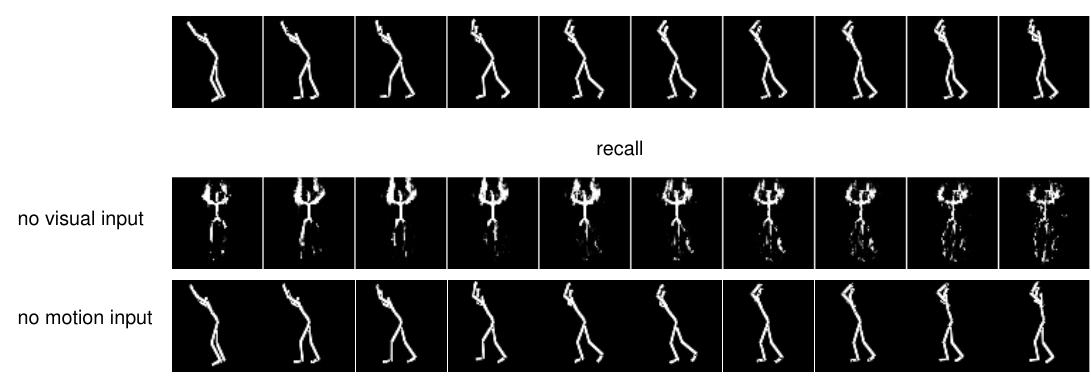
Figure 9: Another example of visual images recalled from the only motion sequence and visualized motion sequence recalled from the only visual image sequence.